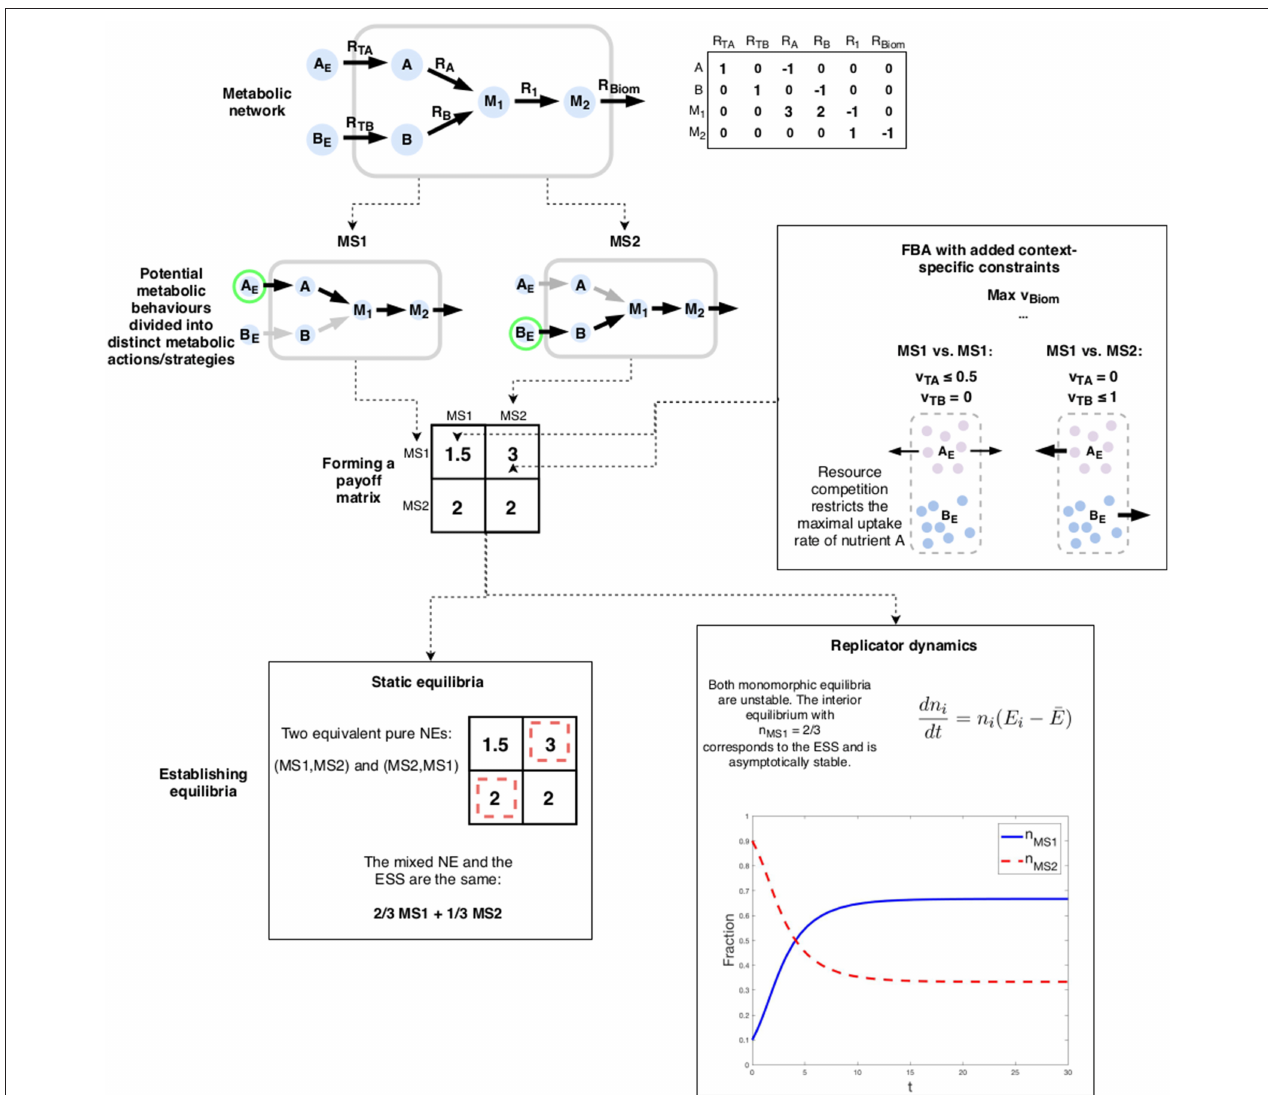
FIGURE 4 | An example of a metabolic game: the choice of nutrient forms the actions of the game. Payoffs are determined using FBA with additional constraints enforcing both the chosen metabolic strategy as well as the impact of the choice of the co-player. The outcome of the game can be analyzed using either static or dynamic solution concepts. In this case, both indicate the same result: expected phenotypic